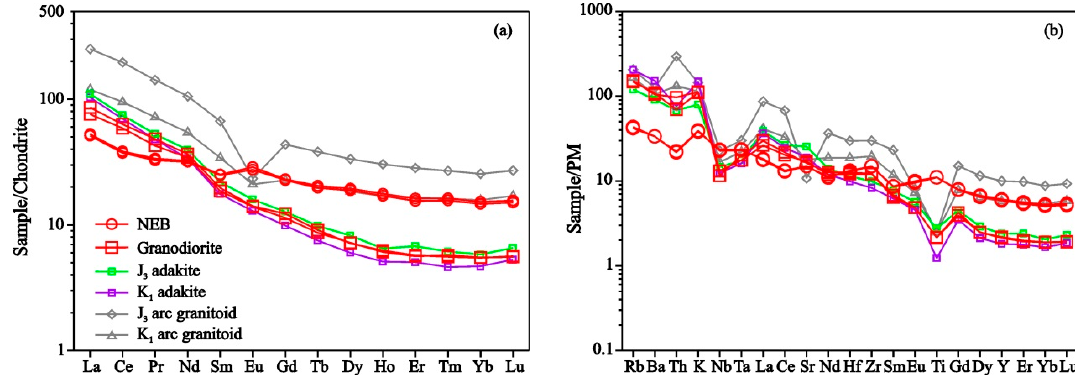
Figure 7. Chondrite-normalized rare-earth element patterns ( a ) and primitive mantle (PM)-normalized trace element spidergrams ( b ) of adakitic granodiorites and NEBs from the Xiaozhenzhu Seamount near the Zhongnan Fault in the SCS. The averaged compositions of the Late Jurassic (J 3 ) adakites (average of 2 samples) and arc granitoids (average of 13 samples) and of the Early Cretaceous (K 1 ) adakites (average of 7 samples) and arc granitoids (average of 16 samples) from the SCS [23,24] are also shown for comparison. The normalizing values are from [55].